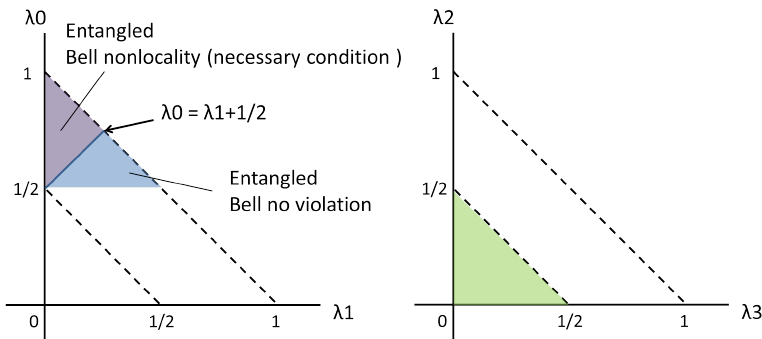
Figure 3. The typical region of { λ µ } revealing the quantum entanglement and the violation of Bell-CHSH